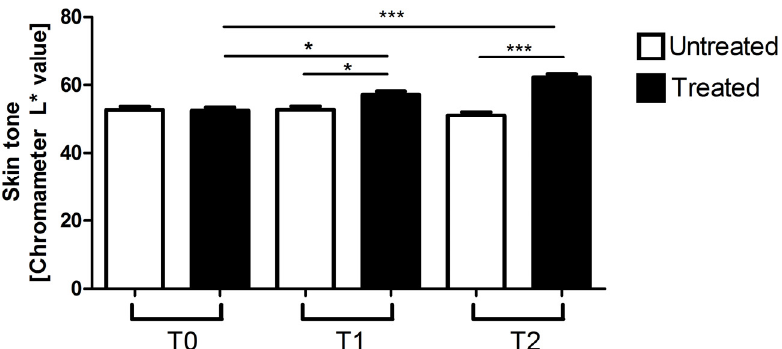
Figure 5. Skin tone at baseline (T0), after one application (T1) and after 4 applications (T2) of the test product in the clinical trial subjects. Untreated (in white) and treated (in black) sides are shown. *** indicates P < 0.0001, * indicates P < 0.05.